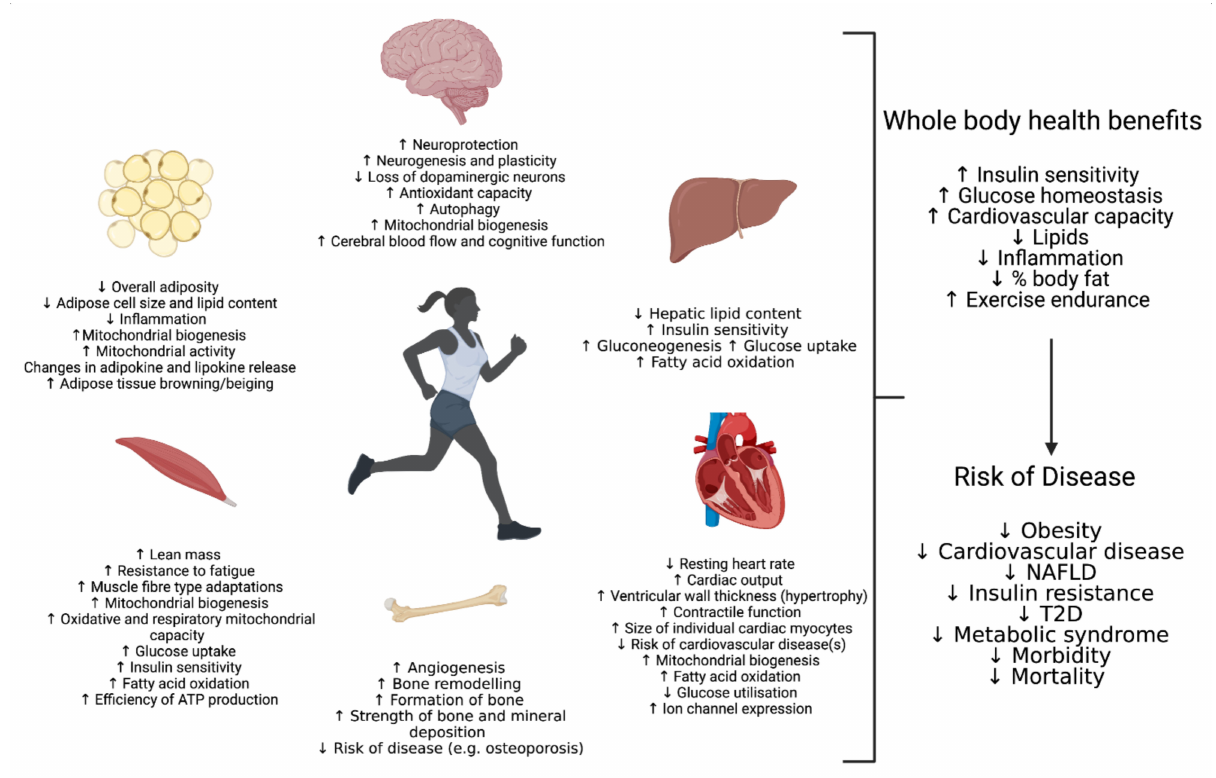
Figure 1. Physiological Adaptations in response to exercise stress in selected metabolic